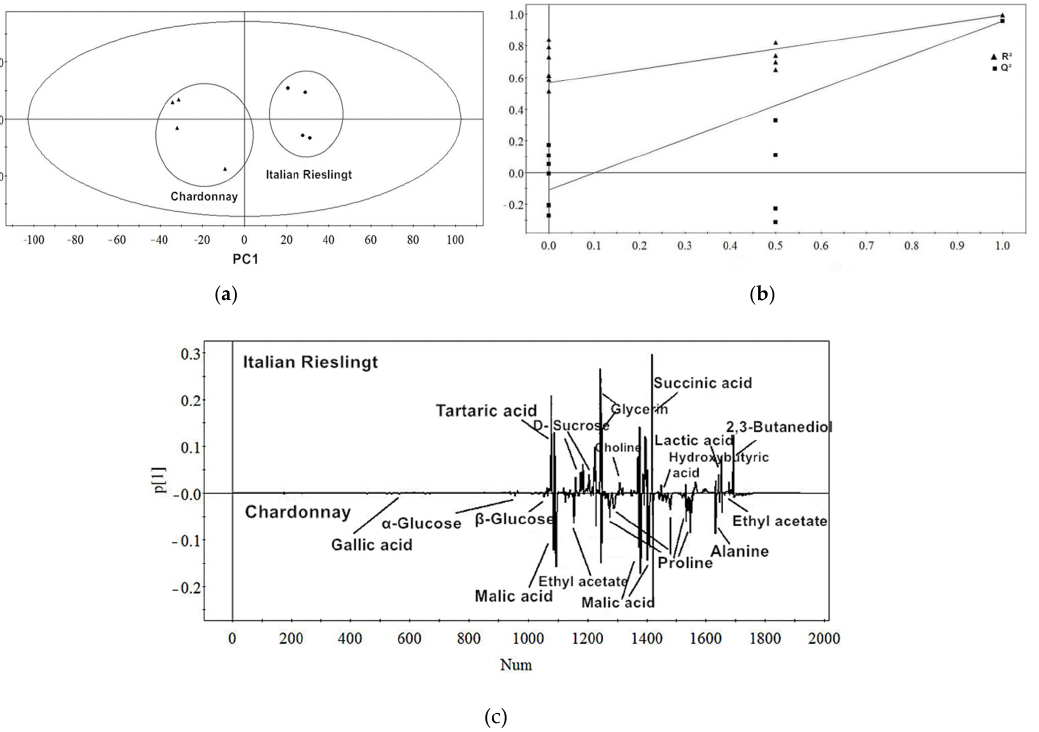
Figure 7. ( a ) PLS-DA model derived from the 1 H-NMR spectra of Chardonnay and Italian Riesling dry white wine. PLS-DA scores plot; ( b ) PLS-DA cross-validation plot; ( c ) PLS-DA loading plot.